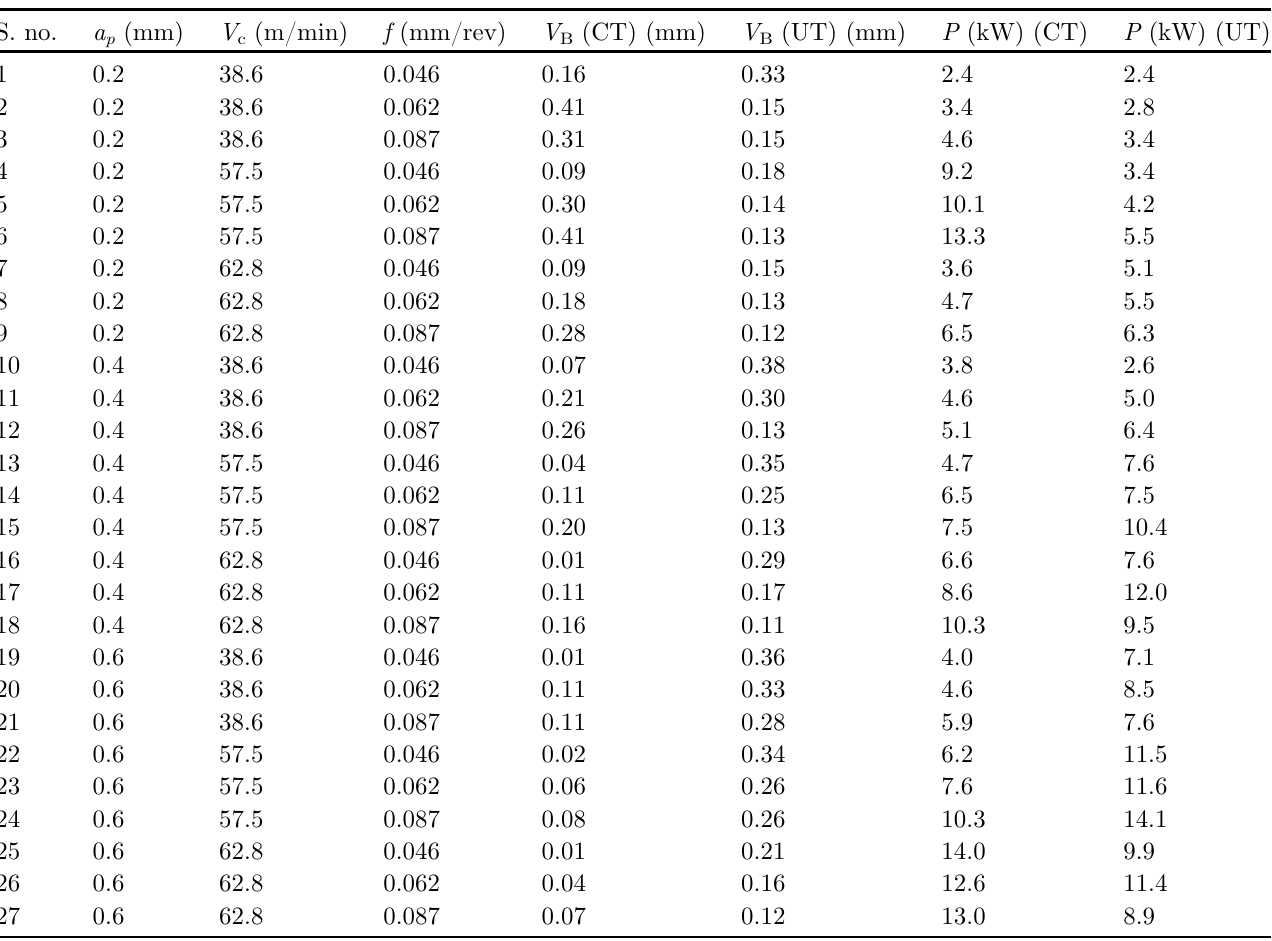
Table 4. Results of quality characteristics of fl ank wear and power consumption for untreated and cryo-treated, respectively.